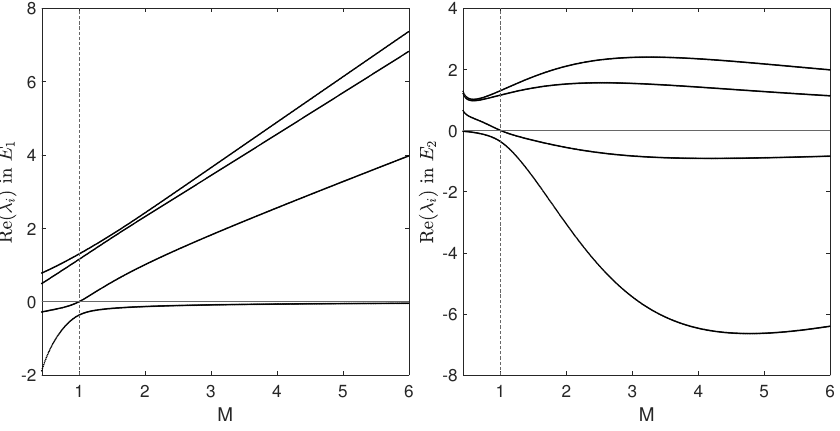
Figure 5. Eigenvalues of the Jacobian J | E of θ : δ = 4, θ = 0.3; Pr = 0.761 as in the reference case: it provides ν = −